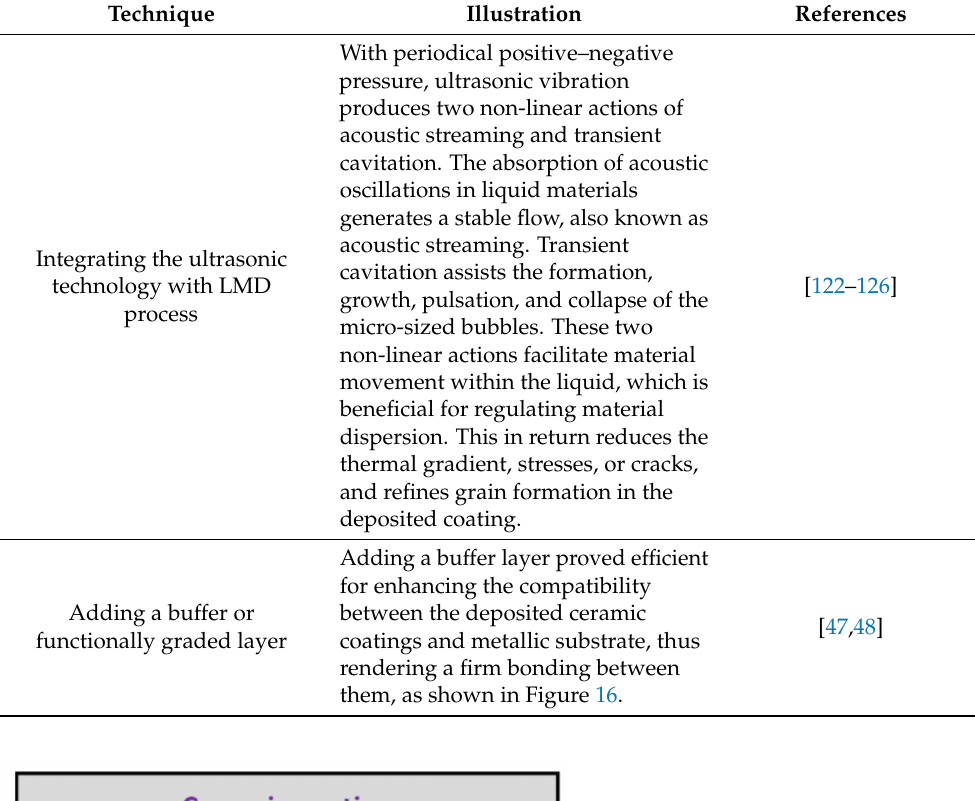
Table 6. Different techniques to optimize the bonding between substrate and coatings. Technique Illustration